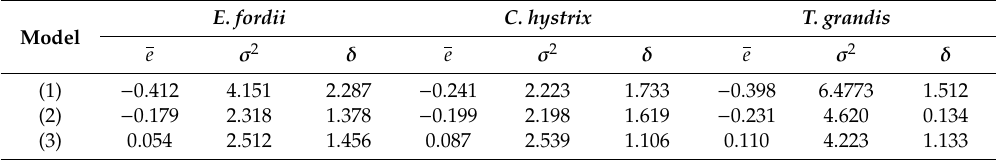
Table 2. Evaluation indexes for models (1)–(3) using the 10-fold cross-validation of Erythrophleum fordii , Castanopsis hystrix and Tectona